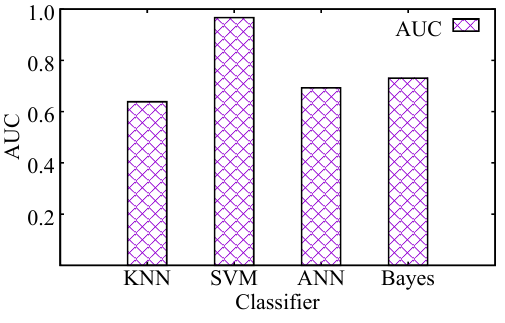
Figure 7. Average prediction accuracy of RUL for six wind turbines. AUC: area under the curve.